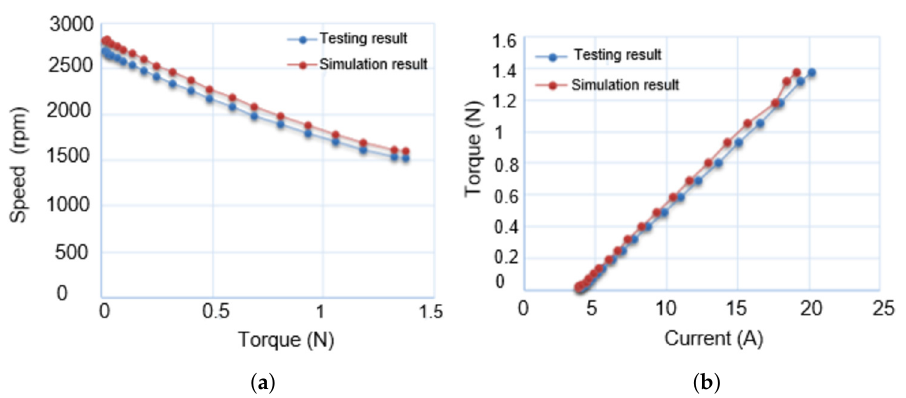
Figure 24. ( a ) Speed vs. torque; ( b ) Torque vs. current.